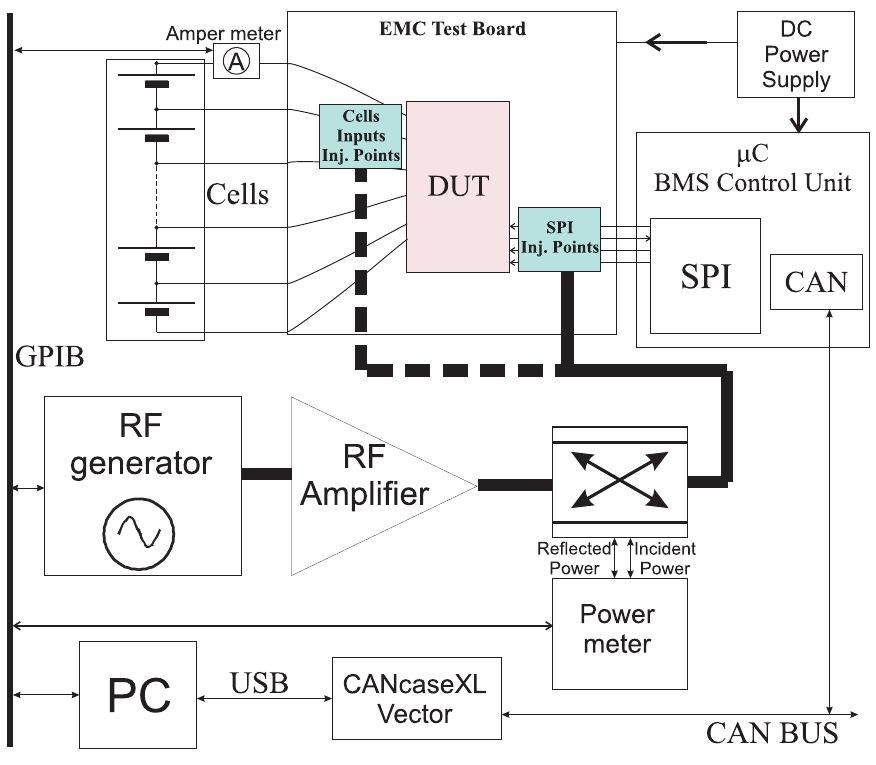
Figure 3. Direct power injection. Experimental test